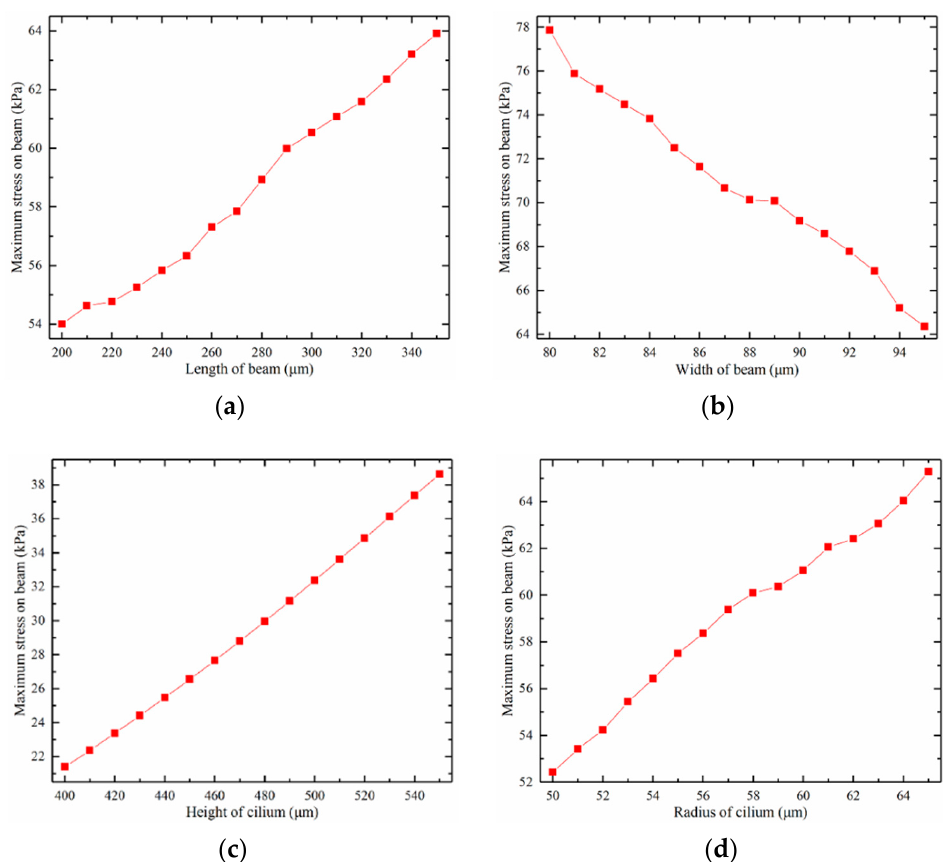
Figure 9. The impact of different structural parameters on the max-stress variation: ( a ) beam length’s impact; ( b ) beam width’s impact; ( c ) cilium height’s impact; ( d ) cilium radius’ impact.